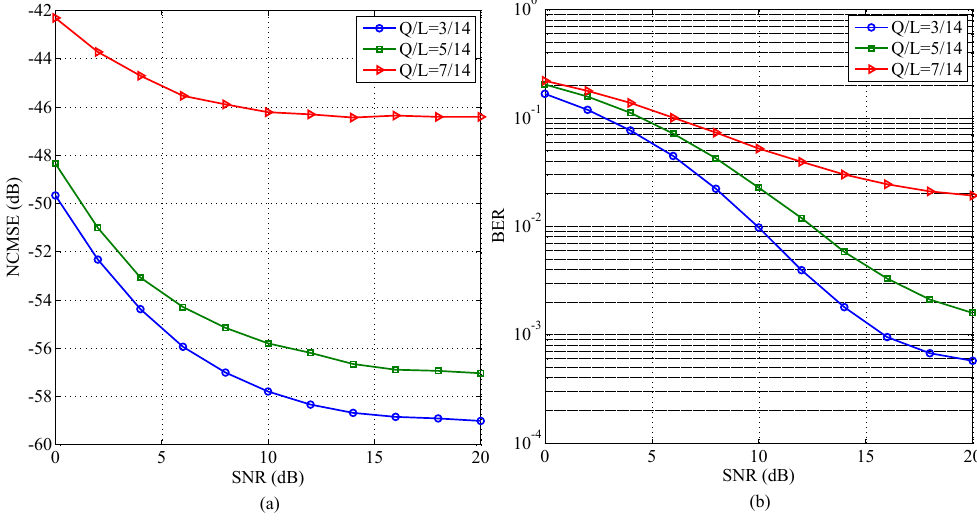
Figure 4. Effect of channel sparsity variation for SiT gradient pursuit (SiT-GP), M = 1500 bits, and = 0.2, ( a ) NCMSE based performance; ( b ) BER based σ 2 c / σ 2 b nt nt